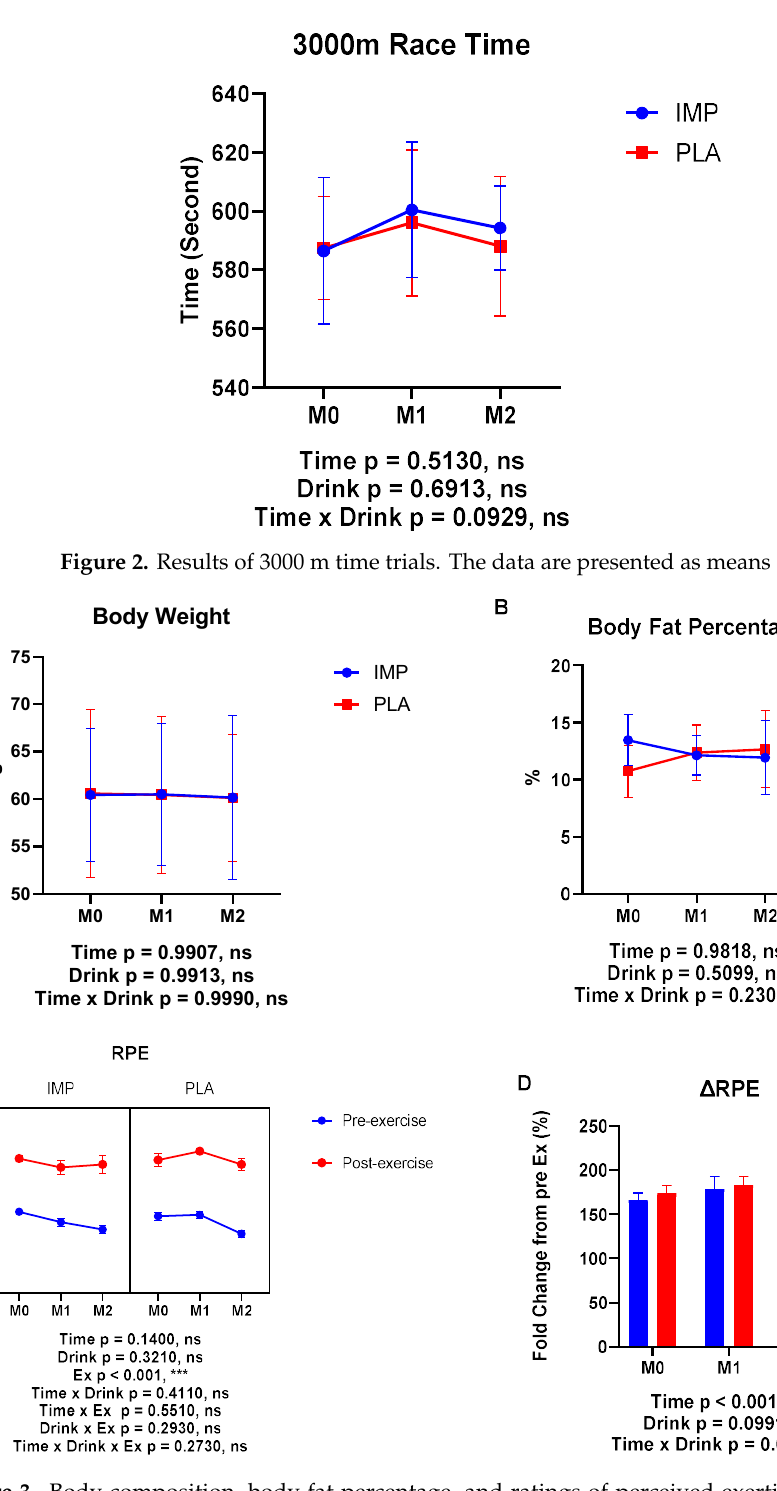
Figure 3. Body composition, body fat percentage, and ratings of perceived exertion (RPE) results. ( A ) Body weight change, ( B ) change in body fat percentage, ( C ) RPE at each time point, and ( D ) RPE change between IMP and PLA. The data are presented as means ± SD. *** p < 0.001.